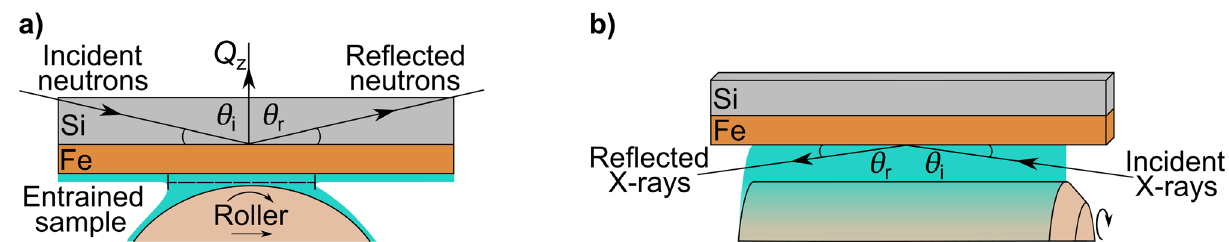
Figure 3. Principal of NR and XRR techniques with tribometer. ( a ) Schematic of NR setup with tribometer. In specular reflection the beam is reflected from the horizontal at an angle θ r , where θ r = θ i . The incident neutron beam illuminates an area that is greater than the meniscus region above the roller. The meniscus held above the roller is outlined by the dashed bracket in the schematic. ( b ) Schematic of XRR setup with tribometer. The incident X-ray beam strikes the horizontal dodecane-substrate interface at θ i